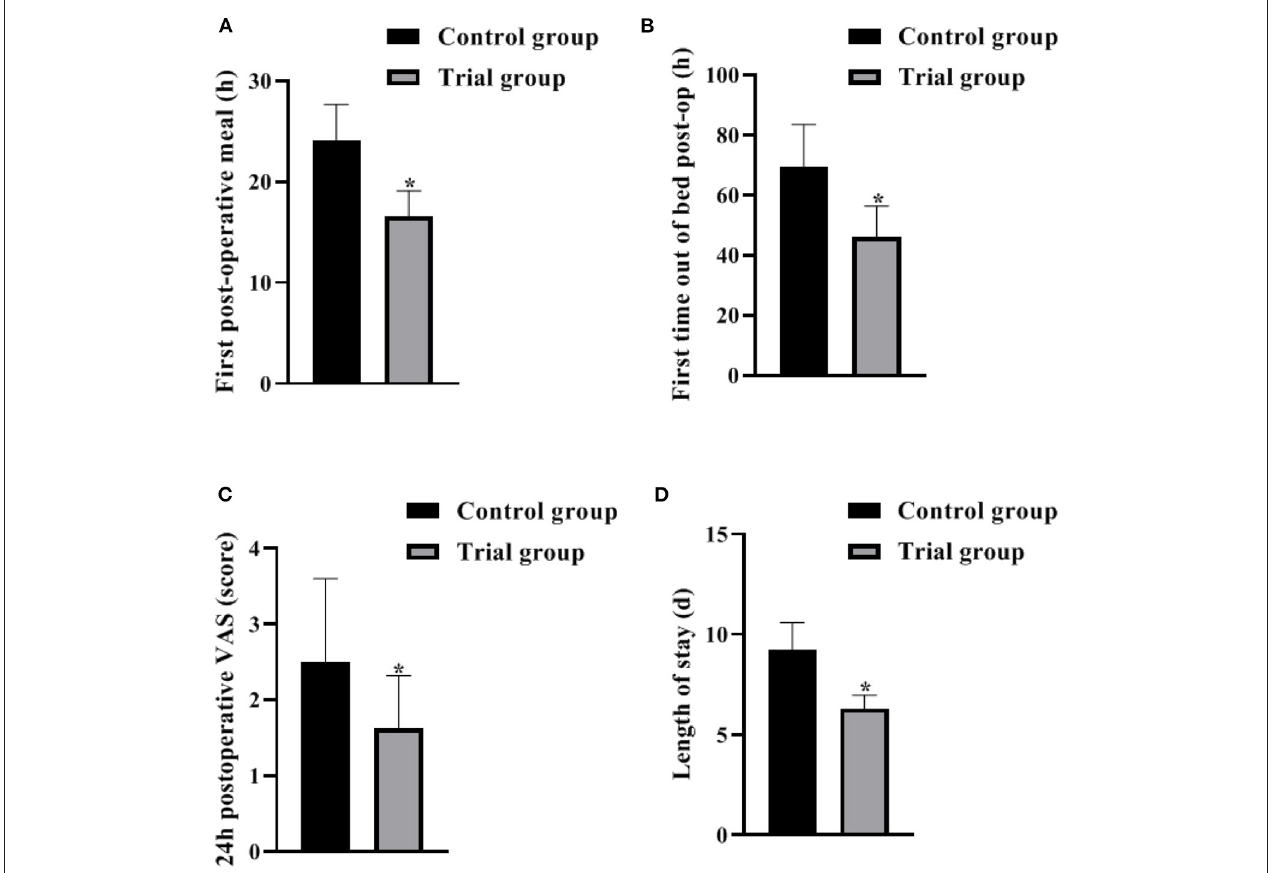
FIGURE 1 | Comparison of perioperative indicators between the 2 groups (Mean, SD). The contents in (A–D) are the first postoperative meal, the first postoperative bed release, and the 24h postoperative VAS score with the length of stay, respectively. The difference between the two groups * P < 0.05.